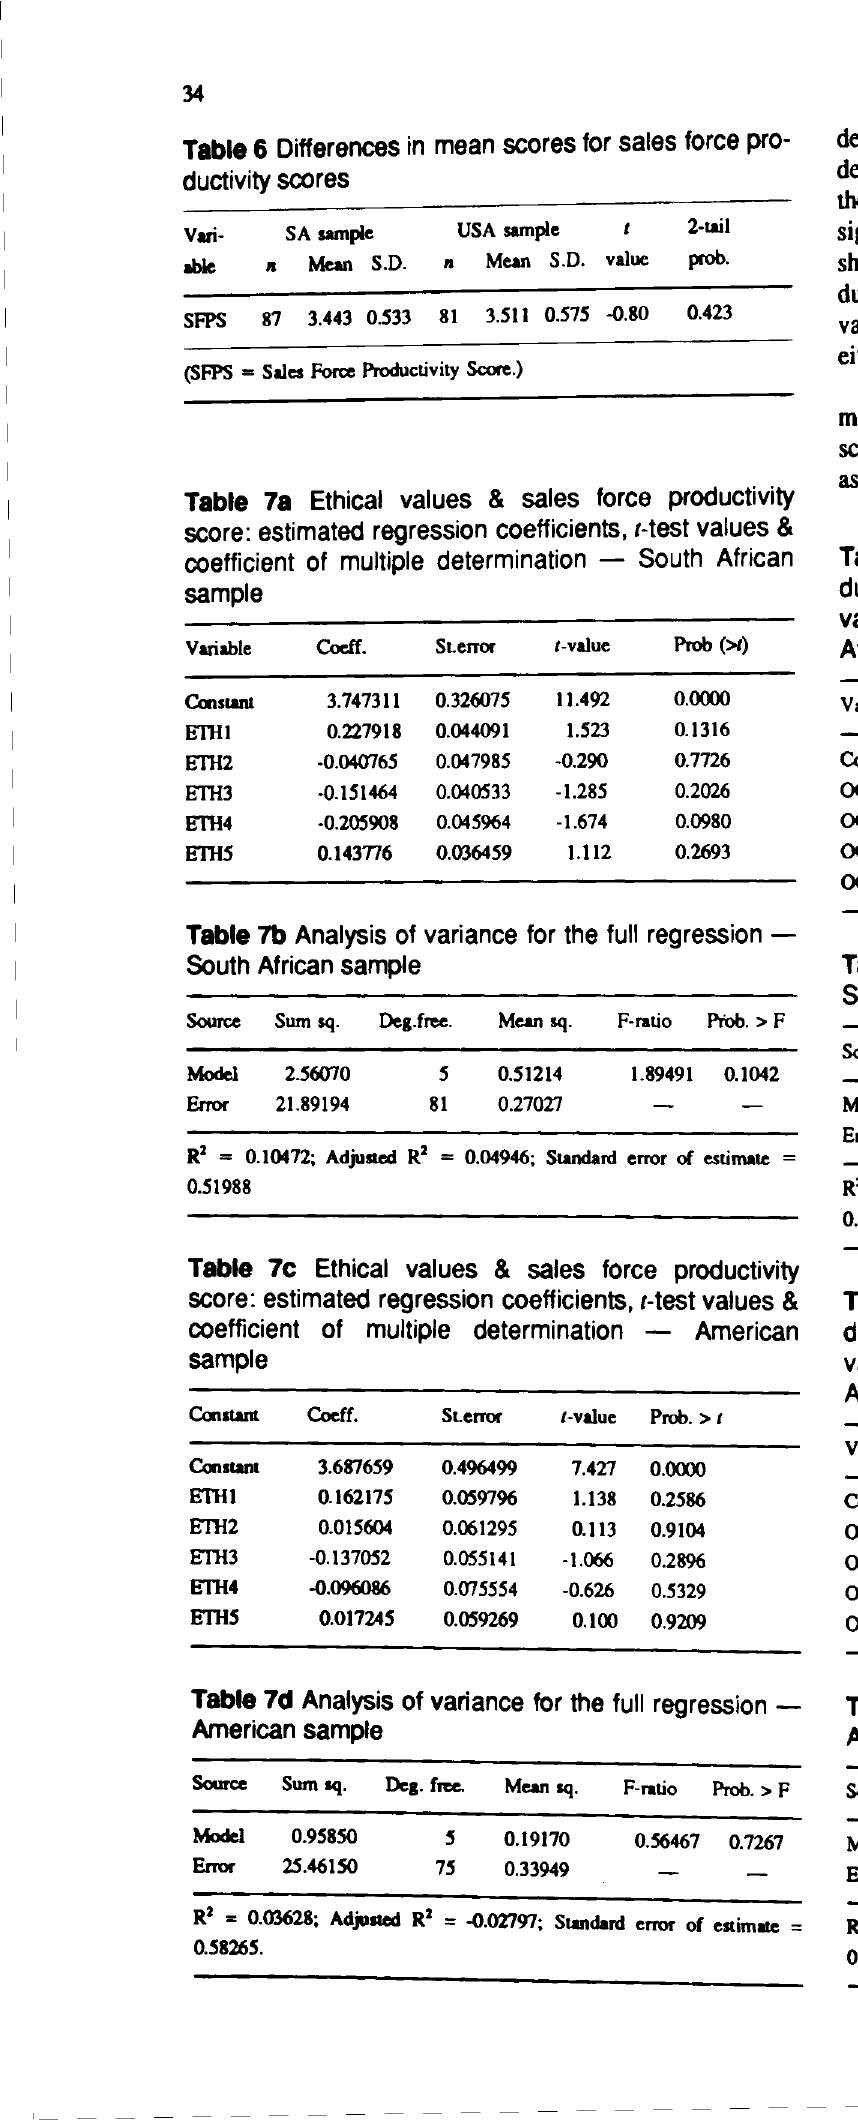
Table 8d Analysis of variance for the full regression